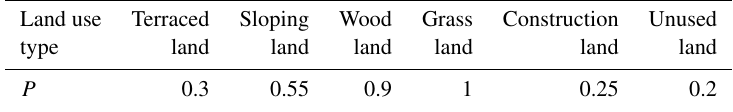
Table 1. Conservation support practice factor ( P ) value.